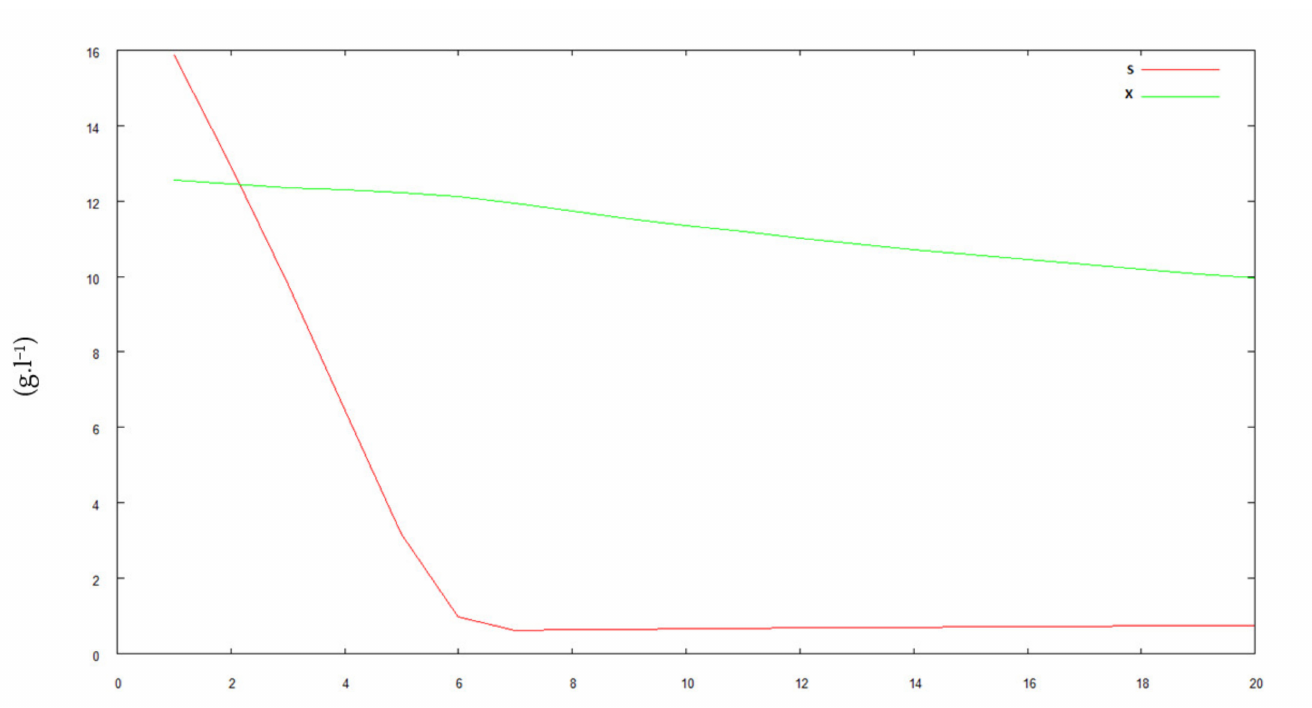
Figure 3. Substrate concentration, S and microorganisms concentration, X .